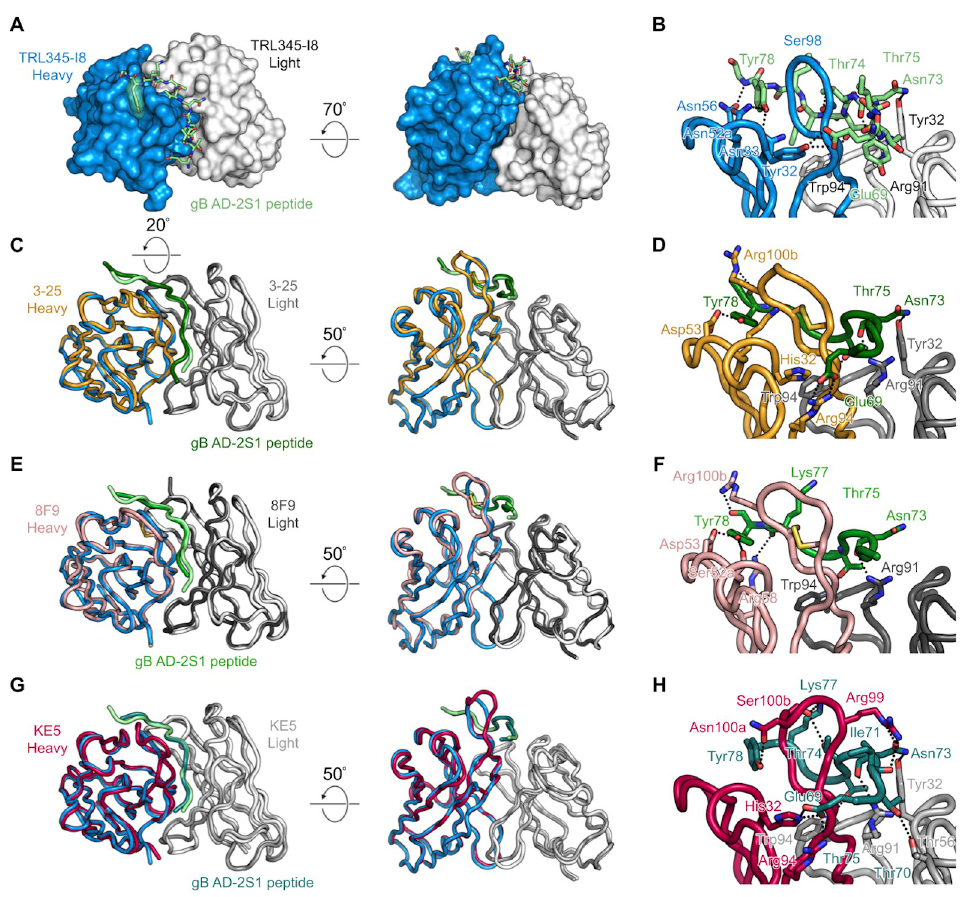
Fig 5. Crystal structure of TRL345-I8 Fab bound to gB AD-2S1 peptide. (A). The TRL345-I8 Fab is shown as a molecular surface, with the heavy chain in blue and light chain in white. The gB AD-2S1 peptide is shown as light green sticks, with residues that form hydrophobic contacts with the TRL345-I8 Fab shown as transparent light green surfaces. (B). The TRL345-I8 Fab interface with the gB AD-2S1 peptide. (C). Superposition of TRL345-I8 Fab and 3–25 Fab (PDB ID: 6UOE) AD-2S1 complexes. (D). The 3–25 Fab interface with the gB AD-2S1 peptide. (E). Superposition of TRL345-I8 Fab and 8F9 Fab (PDB ID: 3EYF) AD-2S1 complexes. (F). The 8F9 Fab interface with the gB AD-2S1 peptide. (G). Superposition of TRL345-I8 Fab and KE5 Fab (PDB ID: 4HHA) AD-2S1 complexes. (H). The KE5 Fab interface with the gB AD-2S1 peptide. In all panels, the TRL345-I8 heavy and light chains are colored blue and white, respectively, and the AD-2S1 peptide to which it is bound is colored light green. In panels B, D, F, and H, Fabs and bound peptides are shown as ribbons, with interacting residues shown as sticks. Hydrogen bonds and salt bridges are shown as black dotted lines. Oxygen atoms are red, nitrogen atoms are blue, and sulfur atoms are yellow. Numbering is in the Kabat scheme. germline-encoded amino acids (Fig 1, S4A and S4B Fig). The V interactions in both the L TRL345.I8 and 3–25 complexes are largely shared by the 8F9 and KE5 complexes (Fig 5B–5H). However, the side chain of 8F9 V CDR1 Tyr32 doesn’t interact with the side chain of N73 of L gB AD-2S1 (Fig 5E and 5F), and the side chain of KE5 V CDR2 Thr56 makes an additional L hydrogen bond with the side chain of Thr70 of gB AD-2S1 (Fig 5G and 5H). In all four complexes, the main chain atoms of gB AD-2S1 Thr75, Leu76, and Tyr78 and the side chain of Thr75 form hydrogen bonds with main chain atoms of the V CDR3. How- H ever, whereas the side chain of gB AD-2S1 Thr74 hydrogen bonds with the side chain TRL345. I8 V CDR3 S98, the side chain of Thr74 hydrogen bonds with the main chain of Cys98 of the H 3–25 V CDR3, the side chain of which forms a disulfide bond with Cys100B, stabilizing the H